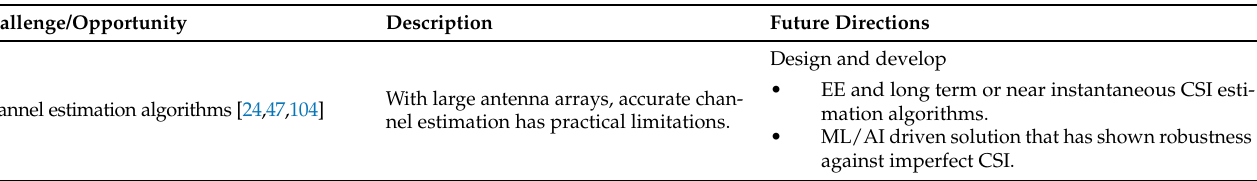
Table 4. Opportunities/Challenges of IRS Technology and Future Research